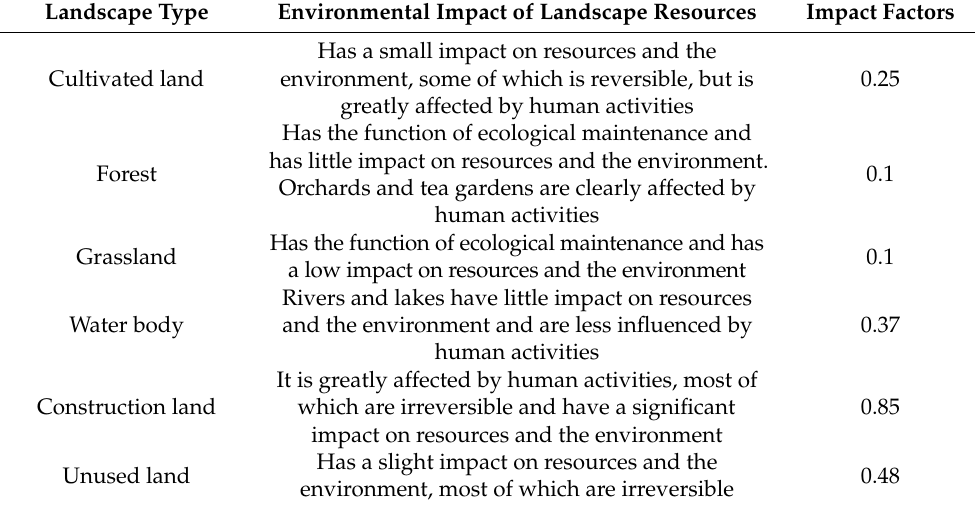
Table 1. Factors affecting landscape resources and the